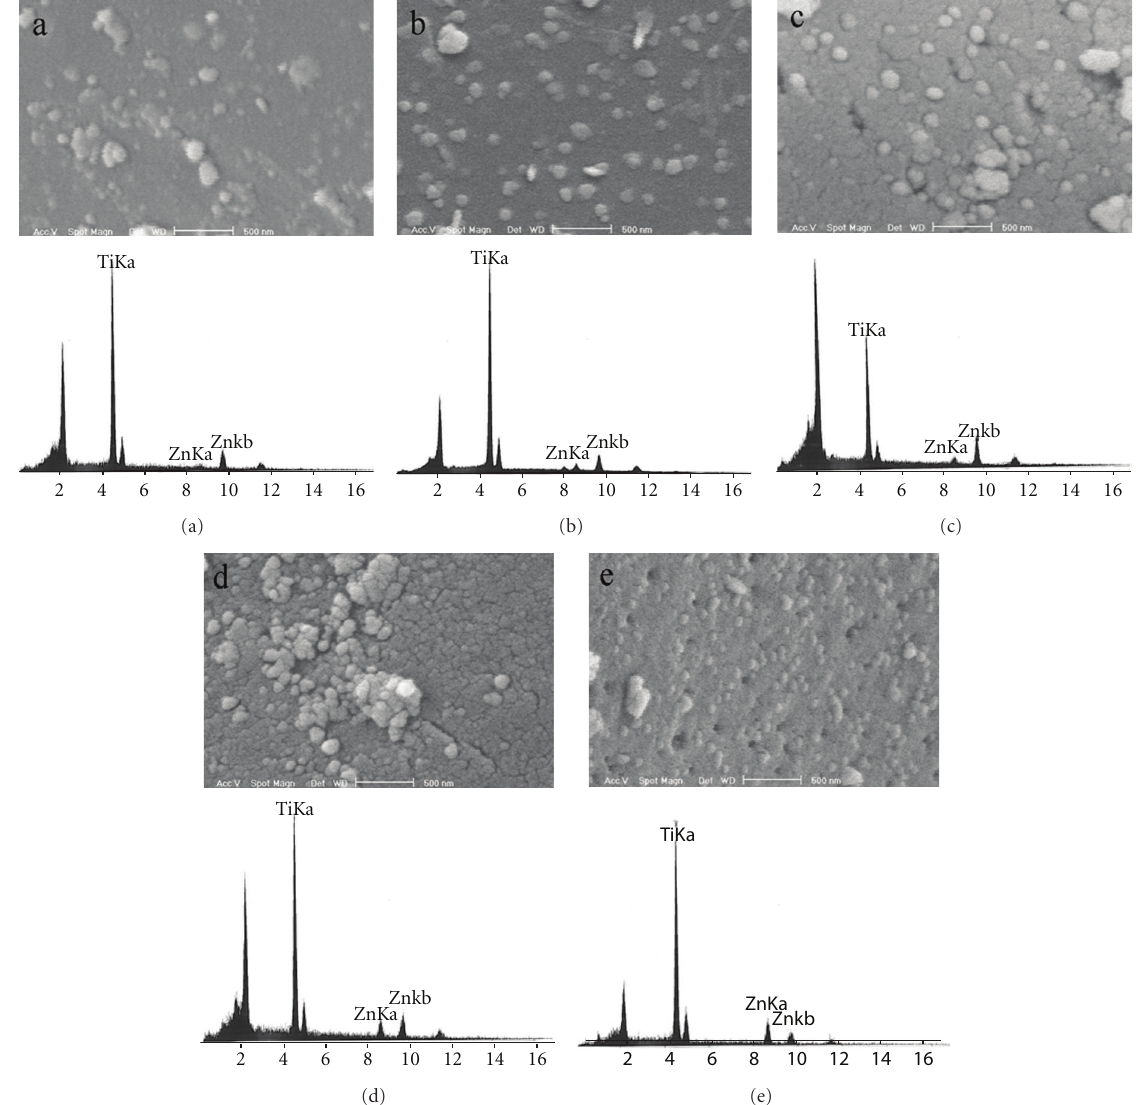
Figure 3: SEM images and EDS analysis of powder